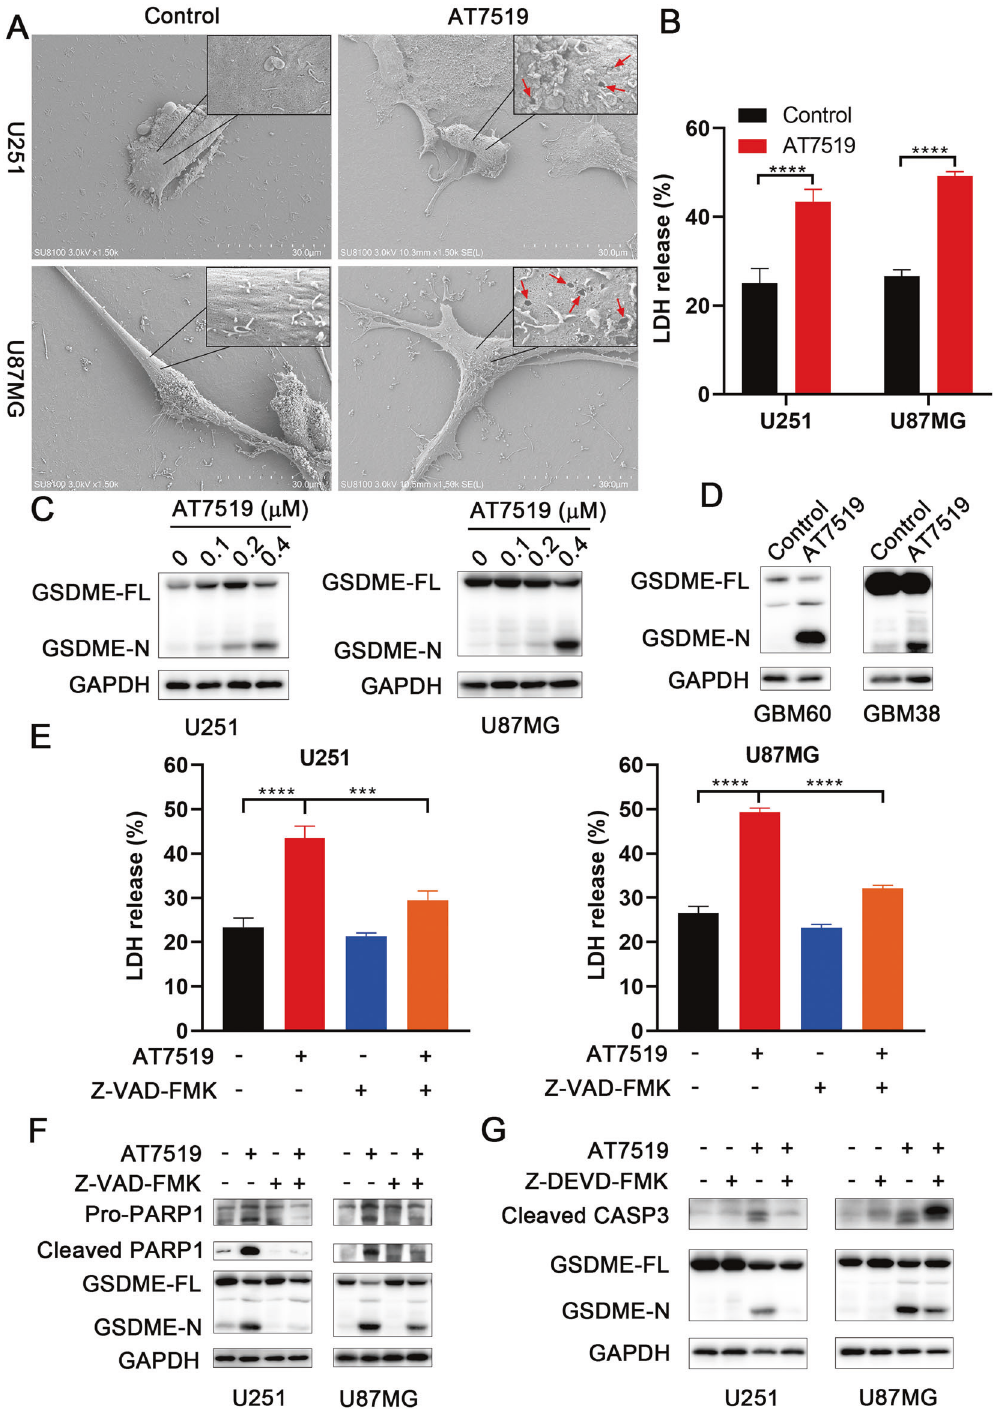
Fig. 5 AT7519 induces pyroptosis through caspase-3 cleavage of gasdermin E. A U87MG and U251 cells were treated with AT7519 and morphological features of pyroptosis in SEM (red arrows, membrane pore-forming). B After U87MG and U251 cells were treated with AT7519 for 48 h, cytotoxicity was detected by lactate dehydrogenase (LDH) released into the cell culture medium. **** P < 0.0001 by Student ’ s t -test. C , D Full-length GSDME (GSDME-FL) and N-terminal GSDME (GSDME-N) were detected in glioblastoma cells after treatment with AT7519 for 48 h by western blot analysis. E , F U87MG and U251 cells were pretreated with Z-VAD-FMK for 2 h and then treated with AT7519 for 48 h. Cytotoxicity was detected by LDH release assay. *** P < 0.001 and **** P < 0.0001 as assessed by Student ’ s t -test. The apoptosis marker cleaved PARP and pyroptosis marker GSDME-N were detected by western blot. G U87MG and U251 cells were treated with Z-DEVD-FMK combined with AT7519 for 48 h, and western blot analysis of cleaved caspase-3, GSDME-FL and GSDME-N proteins was performed.